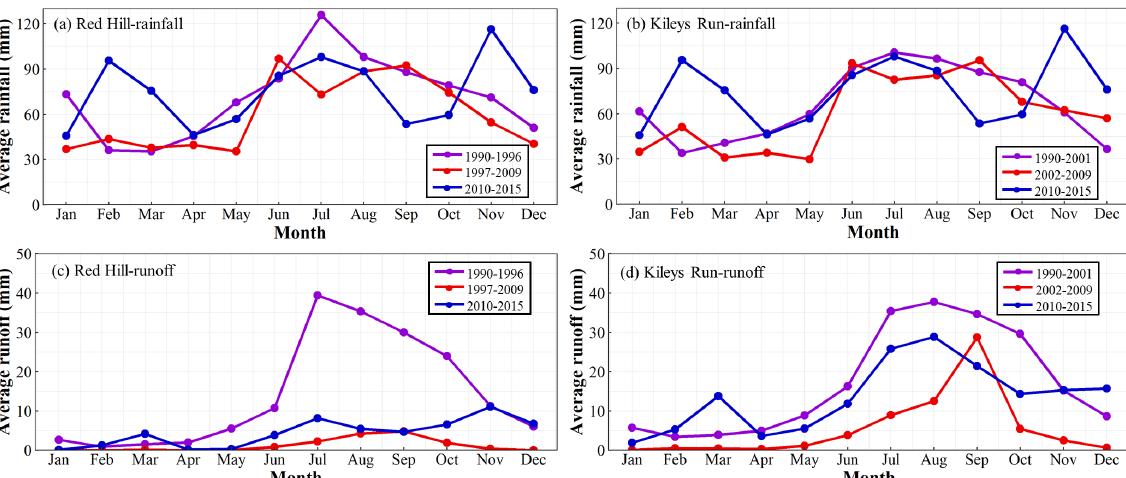
Figure 8. Seasonal changes in (a) monthly rainfall and (c) monthly runoff of the Red Hill catchment (treated catchment), and (b) monthly rainfall and (d) monthly runoff of the Kileys Run catchment (control catchment) during the three different periods (1990–1996,